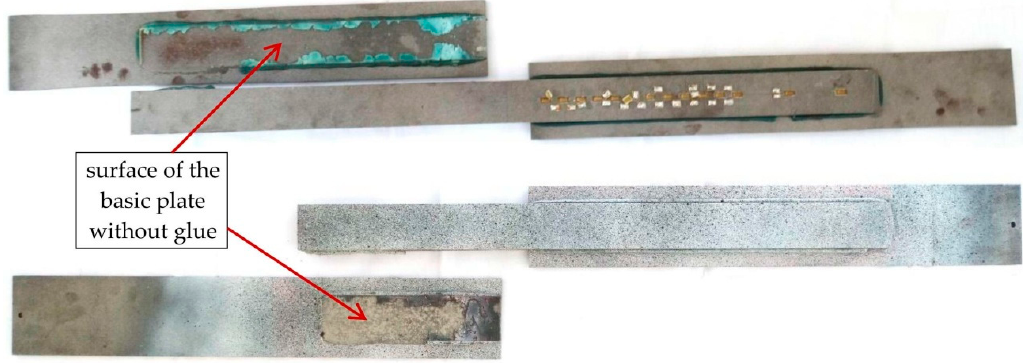
Figure 8. The specimens after failure: Above the element from series S/DL/MA/RS-400/P1 and below the element from series S/DL/MA/RS-200-4/P2.